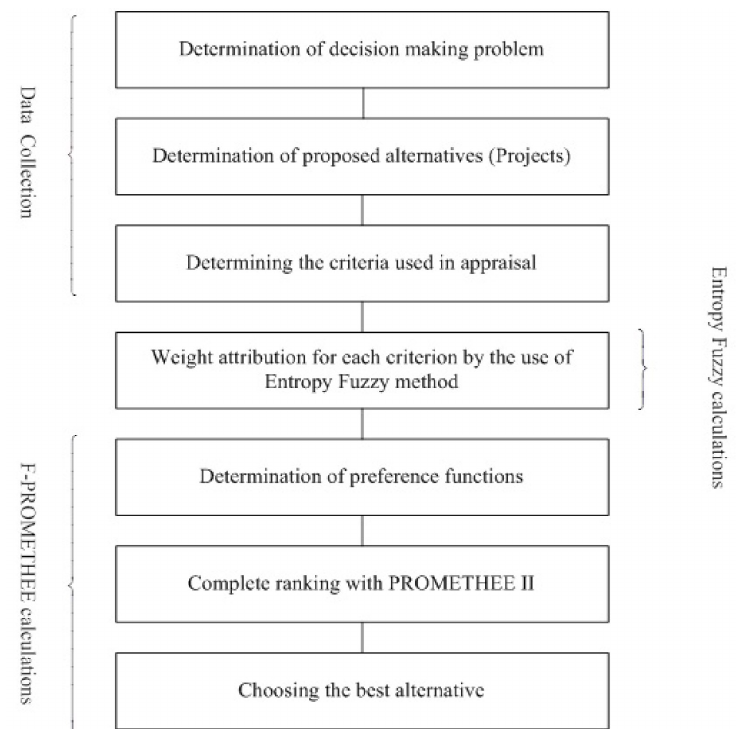
Figure 2. Schematic depiction of the new proposed approach for solving a MCDM problem